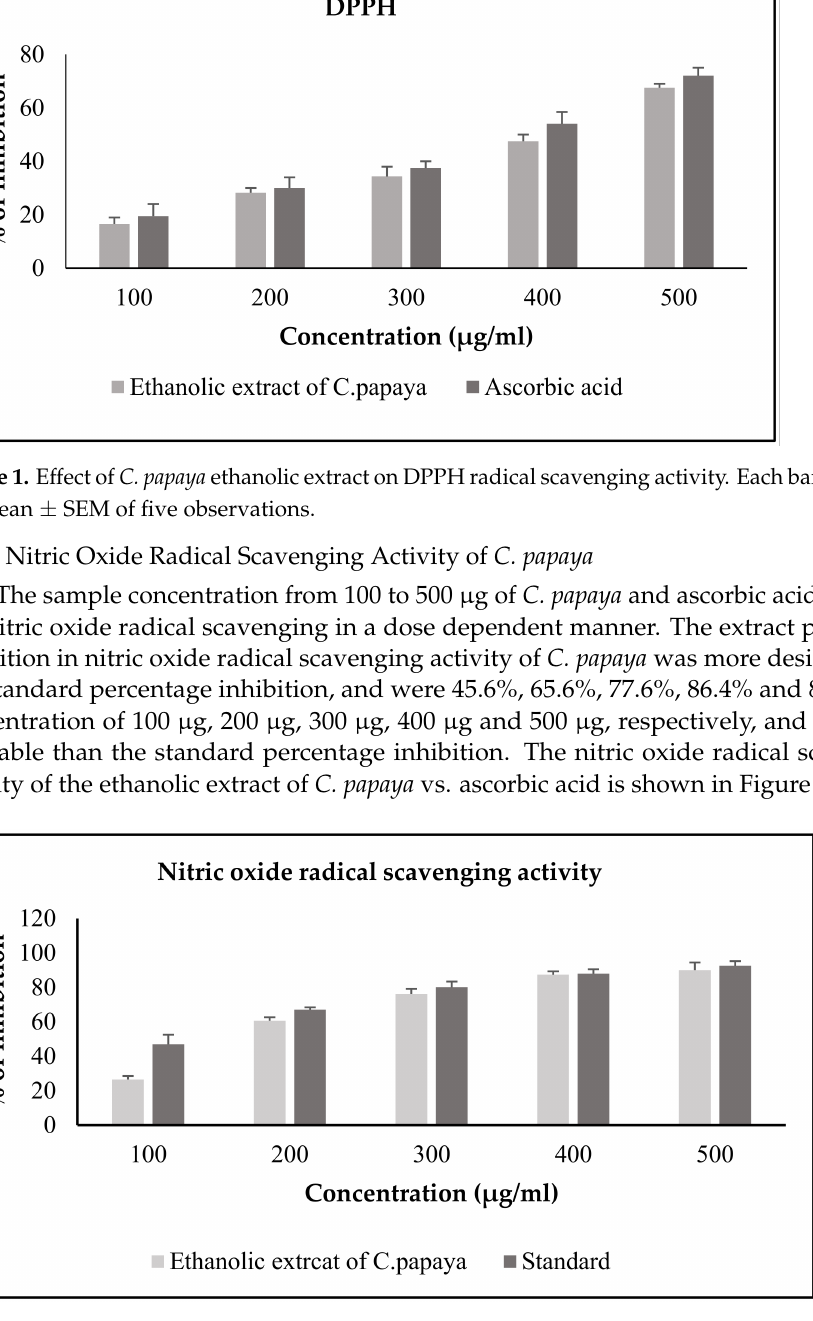
Figure 2. NO radical scavenging activity of the ethanolic extract of C. papaya . Each bar represents the mean ± SEM of five